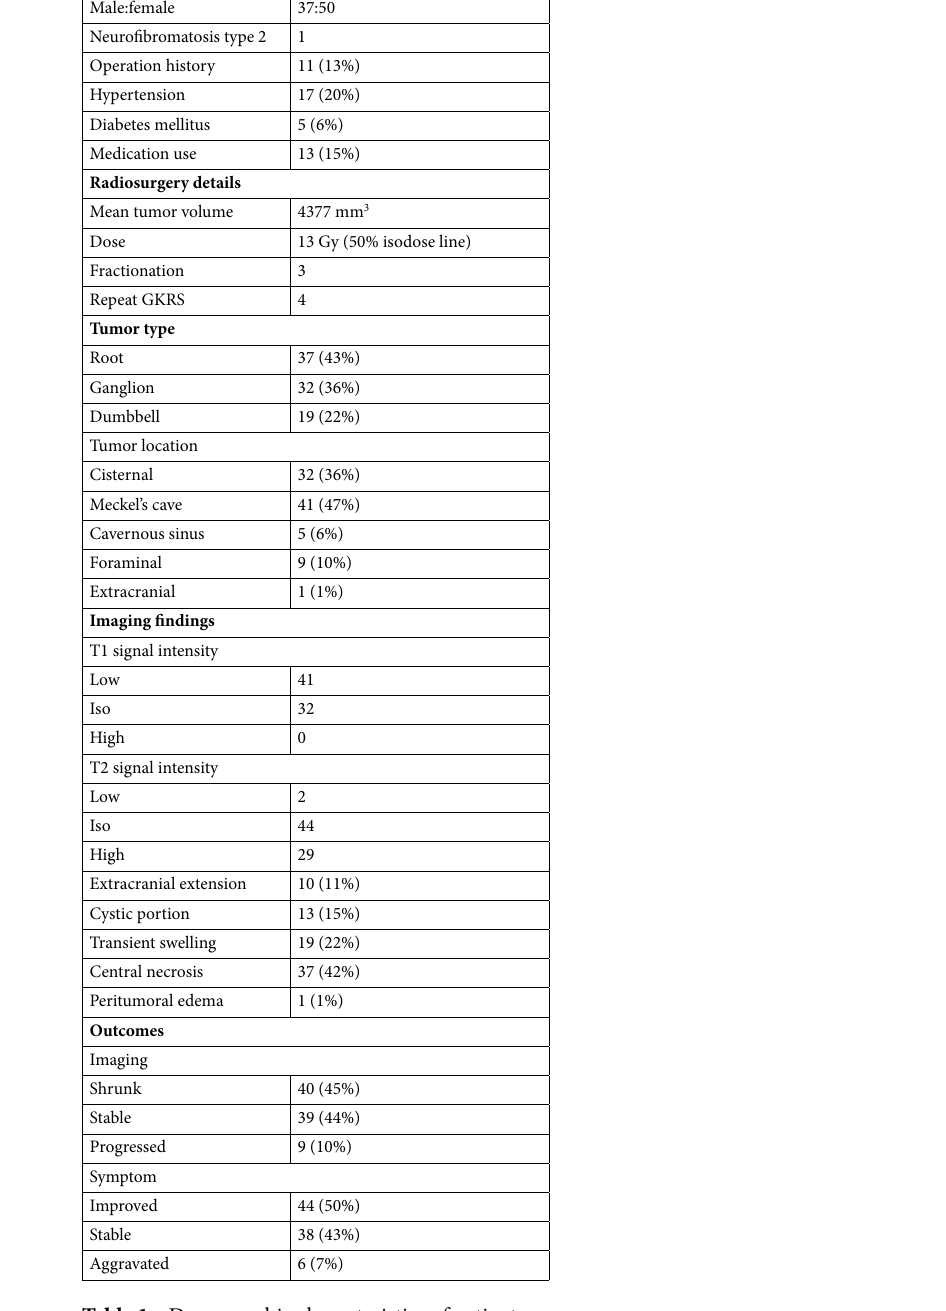
Table 1. Demographic characteristics of